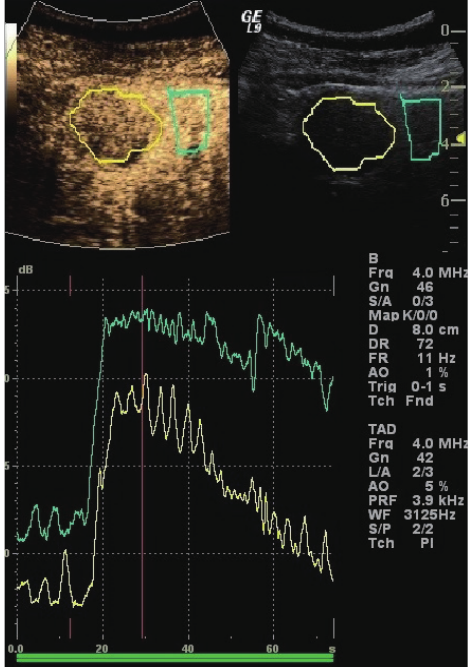
Figure 5 Example CEUS and time-intensity curve analysis of a renal mass later confirmed as papillary RCC on tissue sampling. Top images: Regions of interest are placed around the indeterminate mass (yellow) and adjacent renal cortex (blue). Bottom image: Contrast signal intensity is then plotted as a function of time for each region of interest. Notice the RCC demonstrates faster contrast signal washout relative to the renal parenchyma, a hallmark of